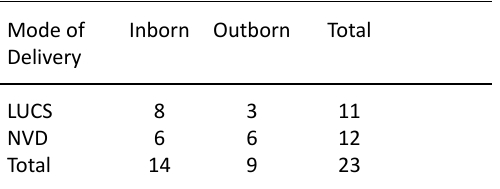
Table 5. Distribution of the babies who died of suspected neonatal septicaemia within the